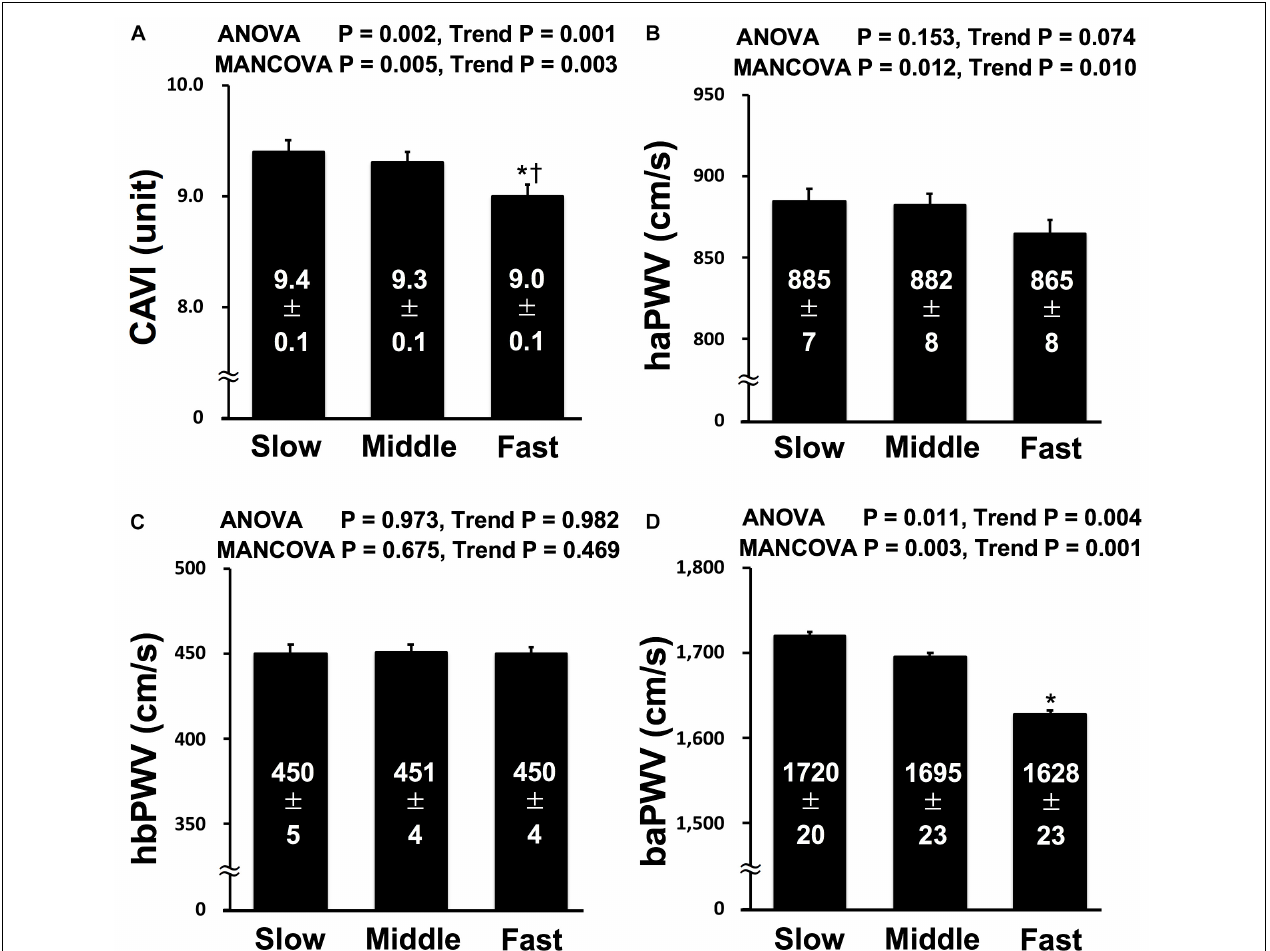
FIGURE 1 | Comparisons of CAVI (A) , haPWV (B) , hbPWV (C) , and baPWV (D) in each tertile. CAVI, cardio-ankle vascular index; haPWV, heart-ankle pulse wave velocity; hbPWV, heart-brachial pulse wave velocity; baPWV, brachial-ankle pulse wave velocity; Slow, lowest tertile ( ≤ 1.54 m/s in men and ≤ 1.49 m/s in women); Middle, middle tertile (1.55 m/s to 1.83 m/s in men and 1.50 m/s to 1.78 m/s in women); Fast, highest tertile ( ≥ 1.84 m/s in men and ≥ 1.79 m/s in women). MANCOVA; the model was adjusted multicollinearity of arterial stiffness indices and confounding factors such as age, gender, body mass index, mean